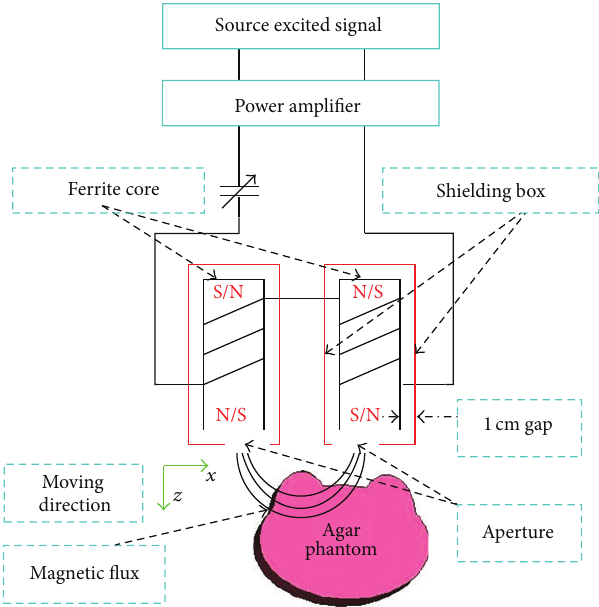
Figure 8: The construction of applicator and shielding system for verifying the numerical and simulation